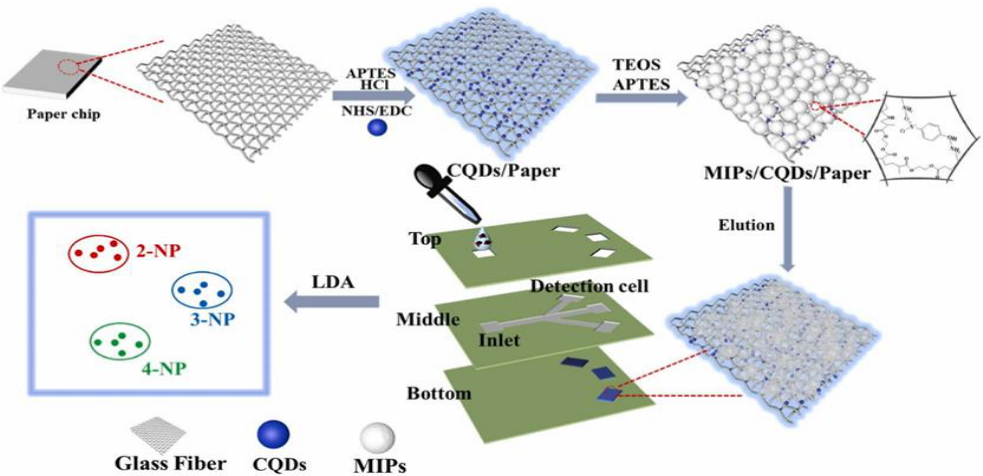
Figure 3. Schematic of the fabrication of a fluorescence sensor-array platform for the detection and discrimination of NP isomers. Reproduced with permission from Ref. [41] . Copyright 2022 Elsevier.